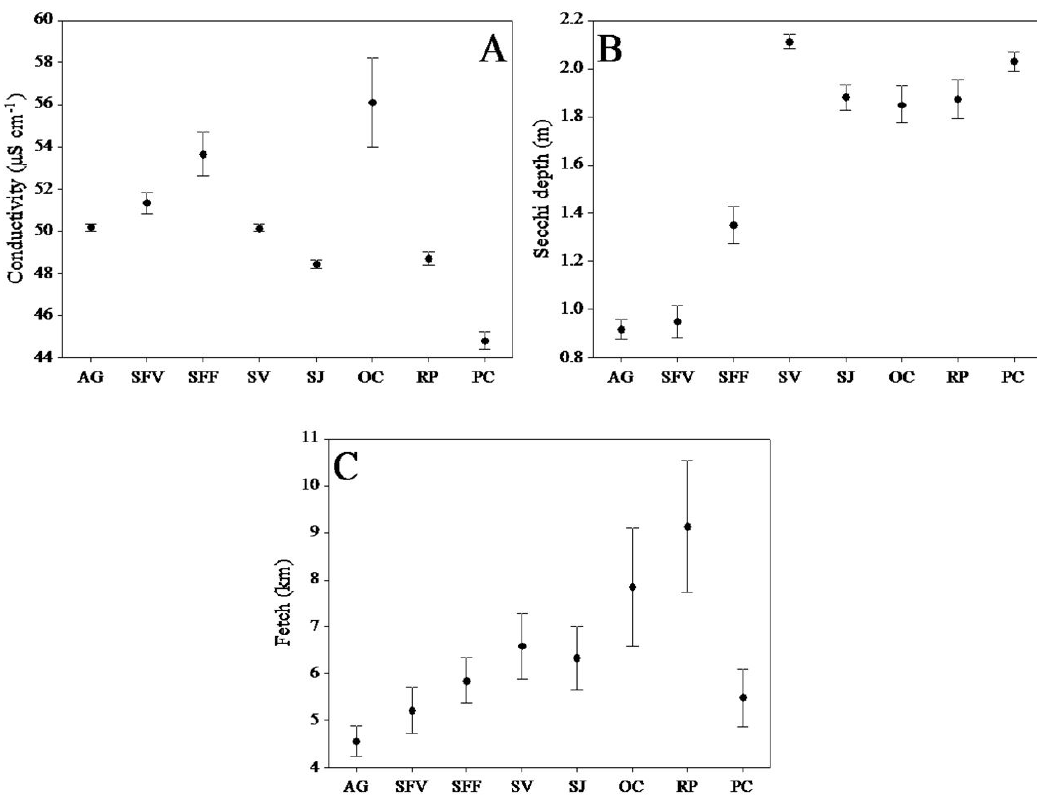
Figure 2. Mean and standard error for conductivity (A), Secchi depth (B) and fetch (C) in each reservoir tributaries. AG = Arroio Guaçu; SFV = São Francisco Verdadeiro; SFF = São Francisco Falso; SV = São Vicente; SJ = São João; OC = Ocoí; RP = Rio Pinto; PC = Passo